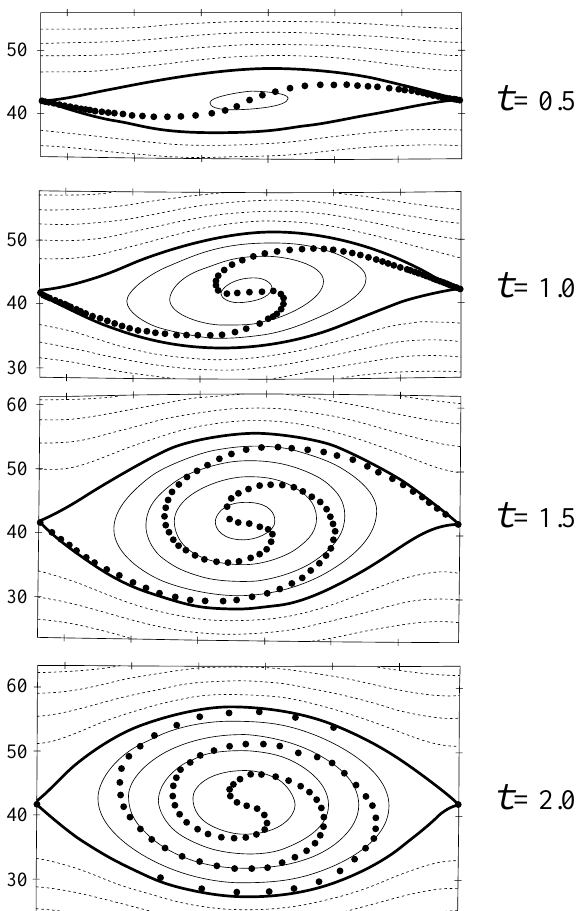
F IG . 5. – Computer simulations of a developing shear instability (Corcos and Sherman, 1984). The four panels show the streamlines at times 0.5, 1.0, 1.5, 2.0 (in units of the initial reciprocal shear). Heavy line is the “cat’s-eye” streamline through the stagnation points. The dots represent particle positions initially placed on the interface; they are initially crowded near the two stagnation points to allow for a subsequent large strain. The model allows for diffu- sion and viscosity. We have reversed the original figure from anticyclonic to cyclonic